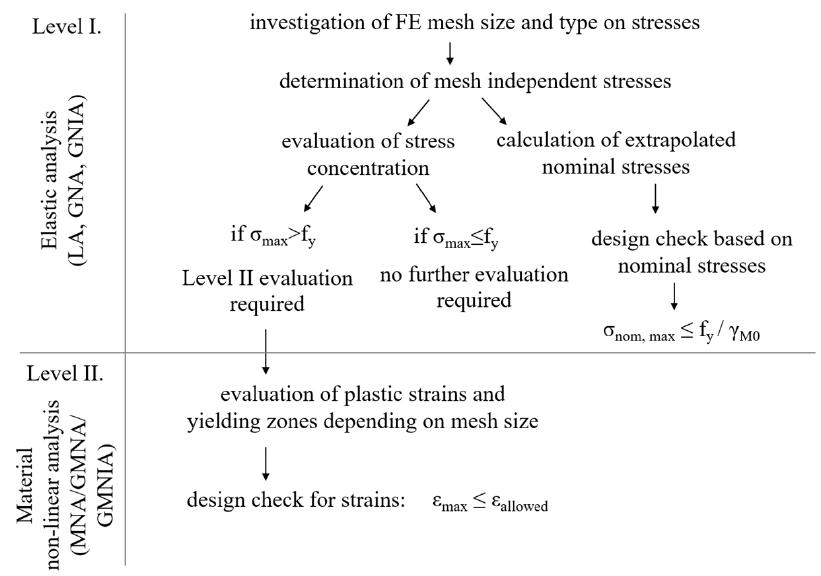
Figure 4. Strategy of the evaluation process for elastic limit state check.